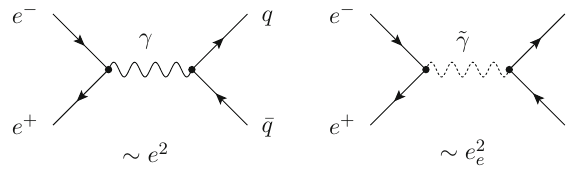
Fig. 1 Diagrams contributing to the process e + e − → γ ∗ → q ¯ q at the tree level. The interaction is mediated by a quasi d -dimensional photon γ (left) and a quasi n (cid:3) -dimensional (cid:3) -scalar photon ˜ γ (right), respectively. The right diagram only exists in